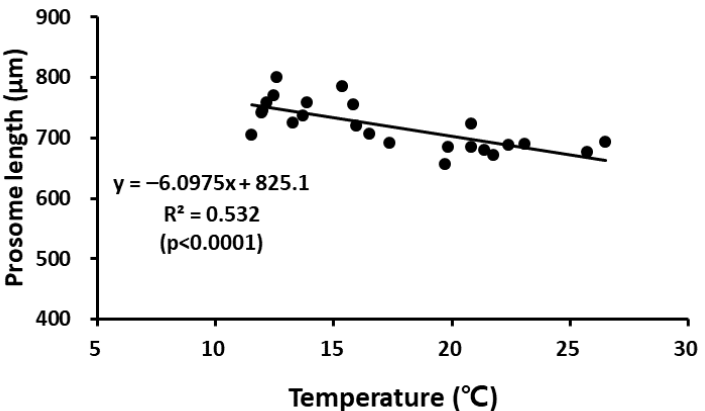
Figure 5. Variation of the prosome length of adult females of P. parvus . Vertical bars indicate the standard deviation.